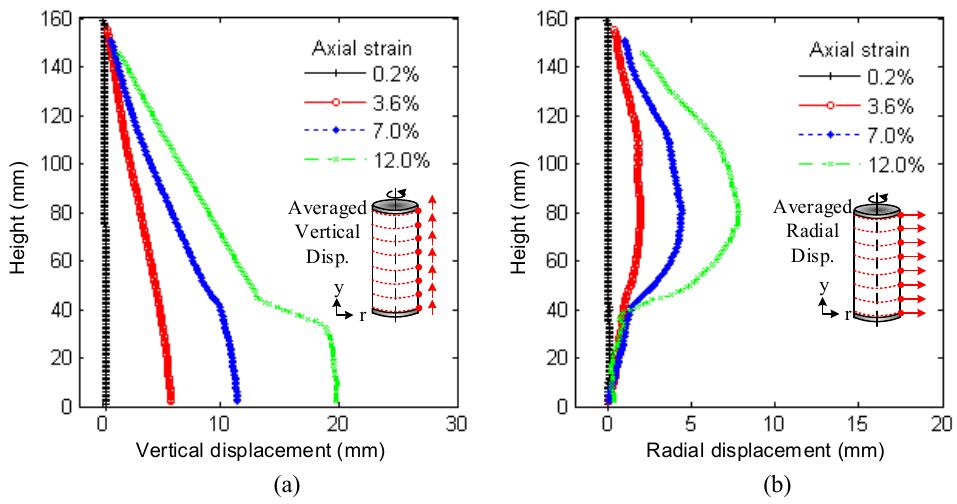
Figure 5. Averaged displacements of the dense sand specimen (120409c): ( a ) vertical displacement ( b ) Radial displacement.